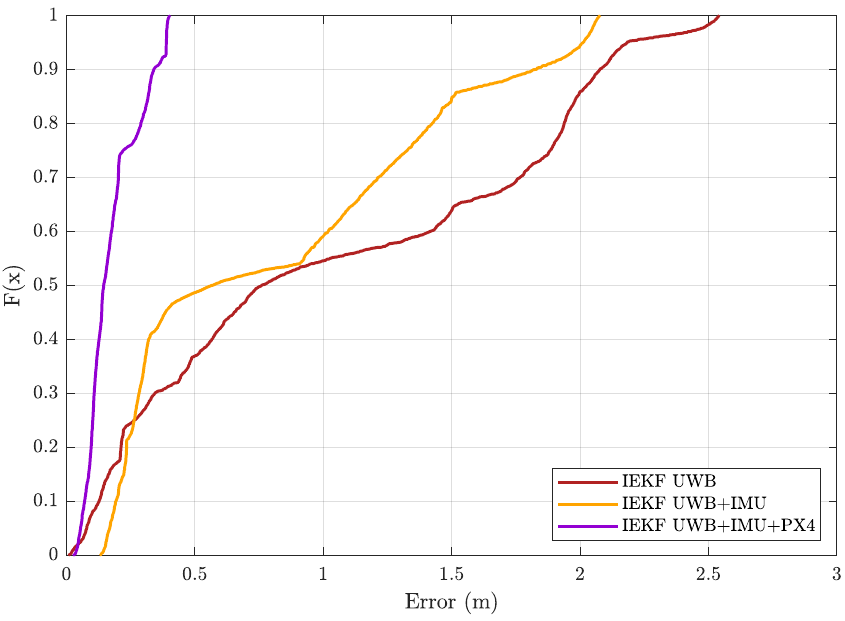
Figure 11. ECDF of position error in scenario